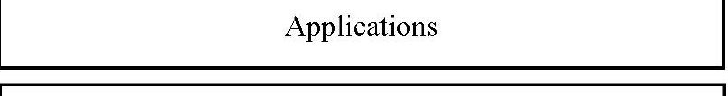
Figure 4. Types of context representation schemes available in